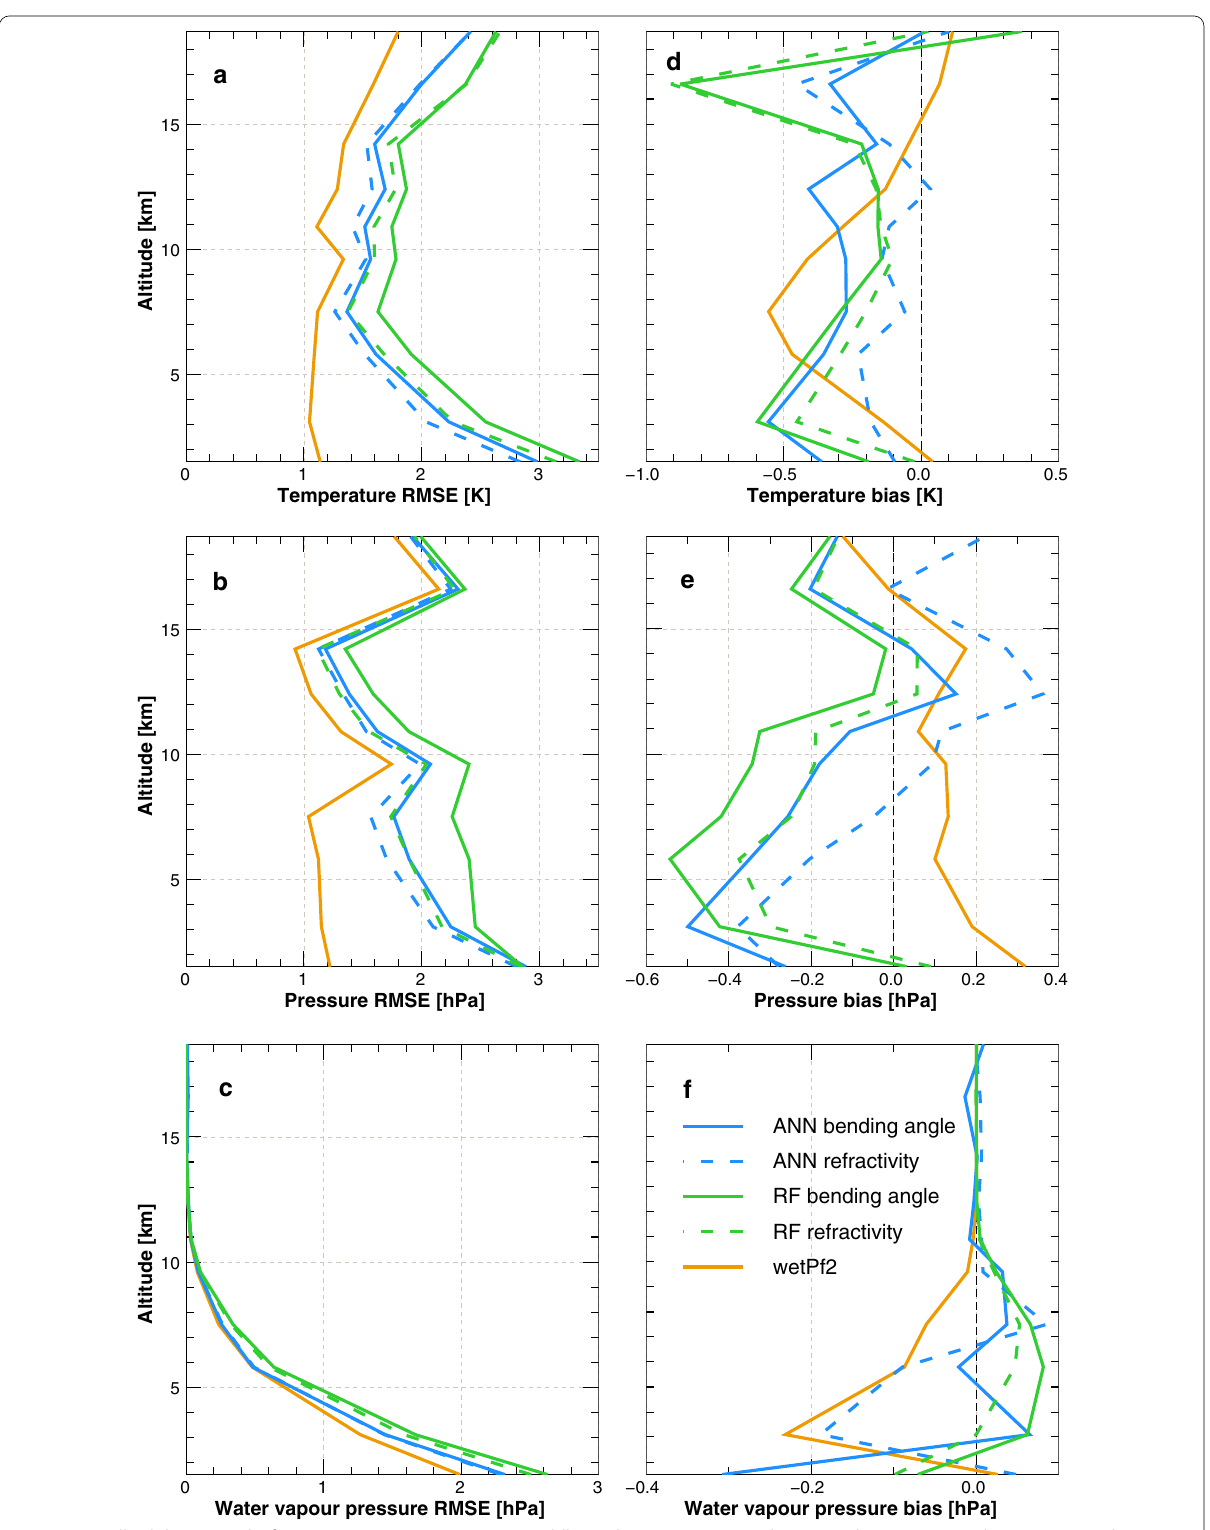
Fig. 6 Overall validation results for temperature (top), pressure (middle) and water vapor partial pressure (bottom). Vertical RMSE ( a – c ) and mean differences ( d – f ) profiles are obtained using ANN (blue lines) and RF (green lines) models with bending angle (solid lines) and refractivity (dashed lines) inputs, official CDAAC wetPf2 product (orange lines) and 477 co-located RAOBS with co-location criteria of 70 km and 2 h time